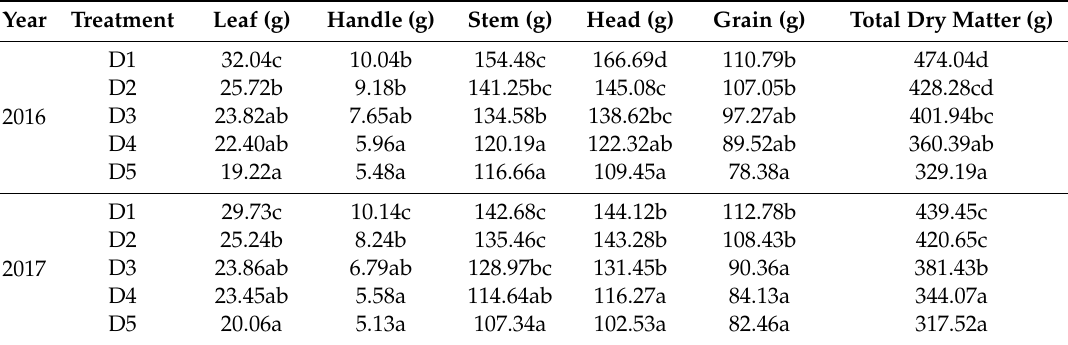
Table 7. The account of dry matter per plant of